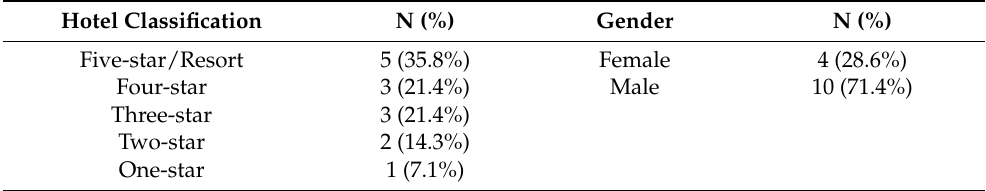
Table 1. Distribution of participant according to gender and hotel